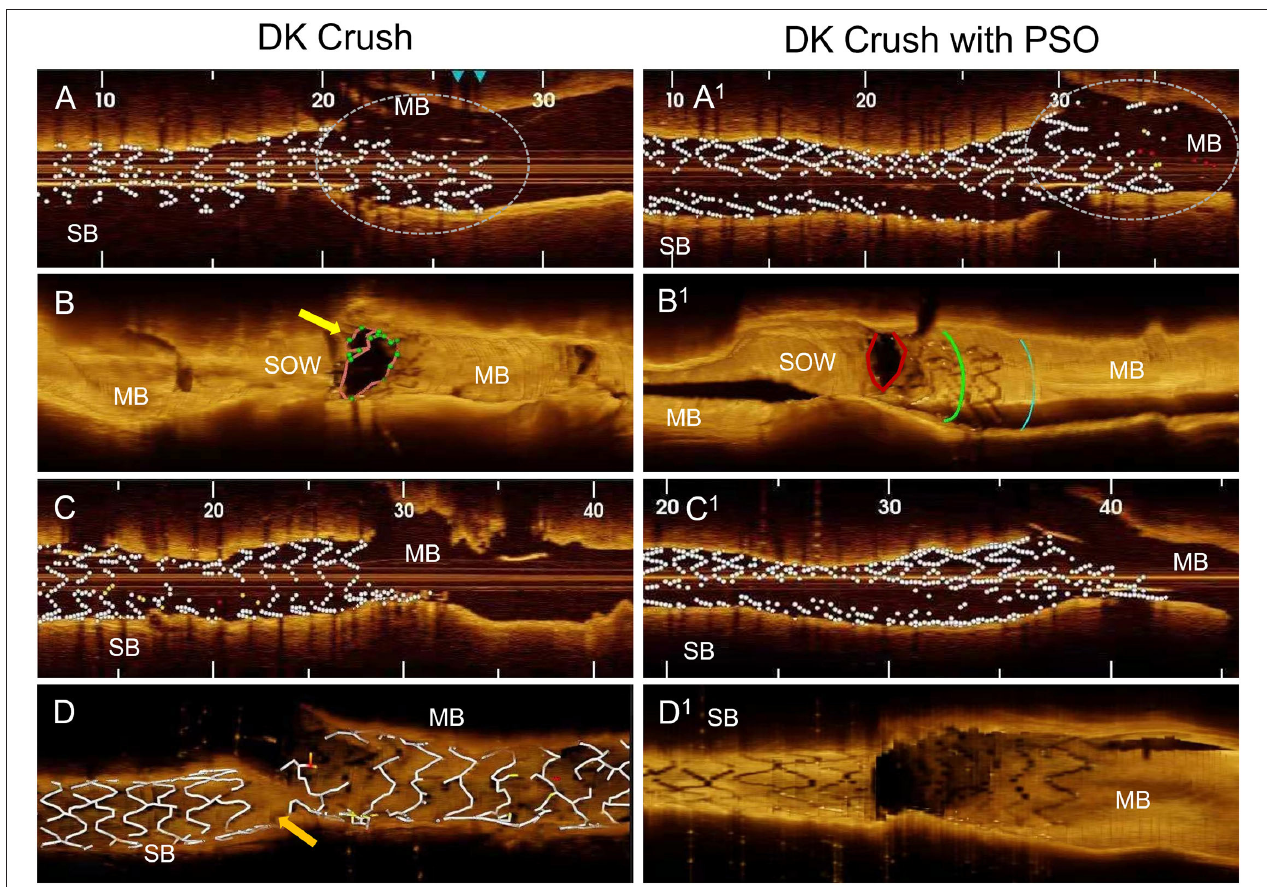
FIGURE 3 | OCT findings in DK Crush compared to DK Crush in PSO modification. (A) After DES implantation on SB at nominal pressure, the OCT shows equal proximal and distal stent diameters, the protruding stent segment in the main branch is under-expanded (circle). (B) After crushing, the SB DES reveals a space between the stent and the ostium of the side branch for inadequate wire passage (yellow arrow). (C) After the first KBI, the stent has tubular shape. (D) After final angiography, depicting a gap in stent coverage in the polygon of confluence (orange arrow). (A 1 ) After DES implantation on SB and PSO modification, shows larger proximal stent diameter compared to distal segment, full apposition of the protruding stent segment into the main branch (circle). (B 1 ) After crushing the SB DES, the optimal apposition to the side branch ostium with no space for inadequate wiring. (C 1 ) After the first kissing balloon inflation, reveals a funnel like shape of the stent. (D 1 ) After final angiography, complete coverage by stents of the polygon of confluence. MB, Main Branch; SB, Side Branch; SOW, Space of Optimal Wiring; PSO, Proximal Side